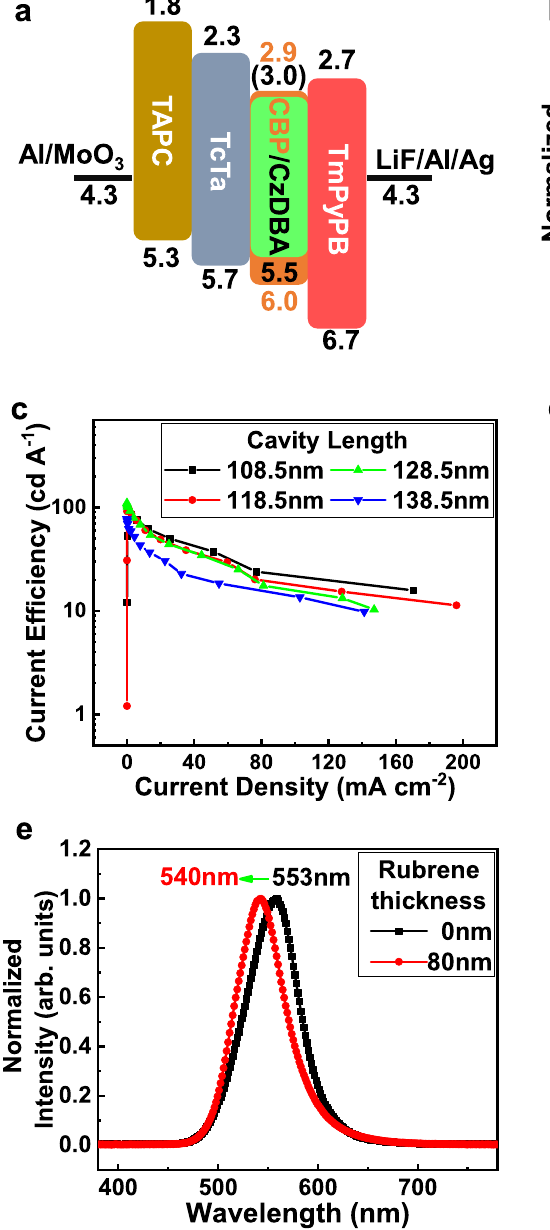
Fig. 3 | TEOLED optimization through microcavity and light extraction mod- ulating. a The energy level alignment. b The normalized EL spectra of TEOLEDs with different cavity lengths. c Current ef fi ciency-current density curves of TEO- LEDs with different cavity lengths. d Theoretical calculation of the luminous re fl ectanceof TEOLED with 128.5nm cavity length as a functionofthe thickness of